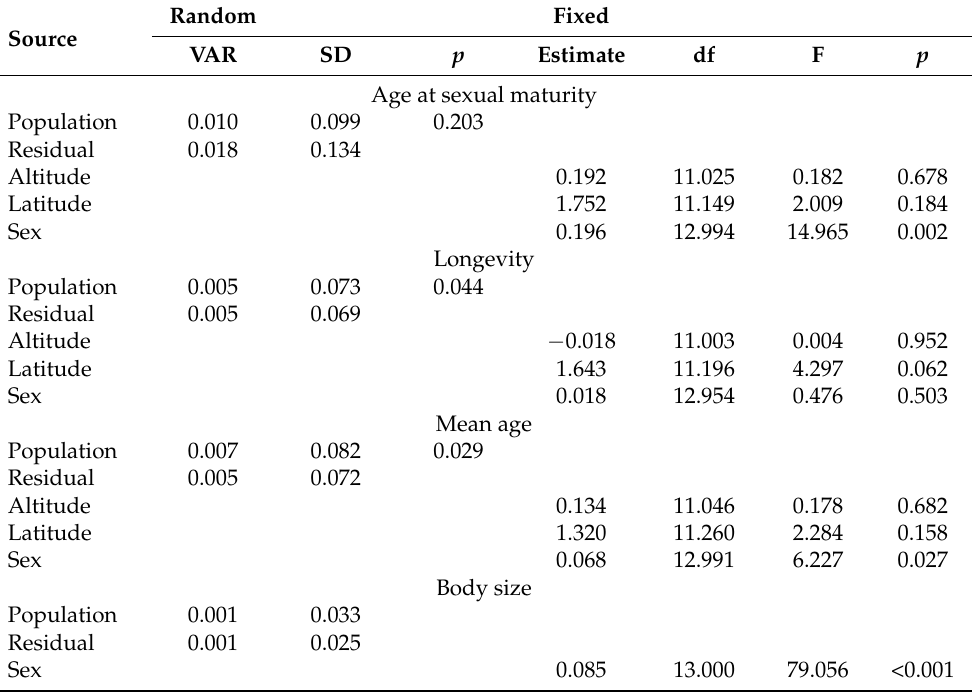
Table 1. The influences of geographic gradients and population on variation in age and body size across 14 populations of Andrew’s toads ( B. andrewsi ) using